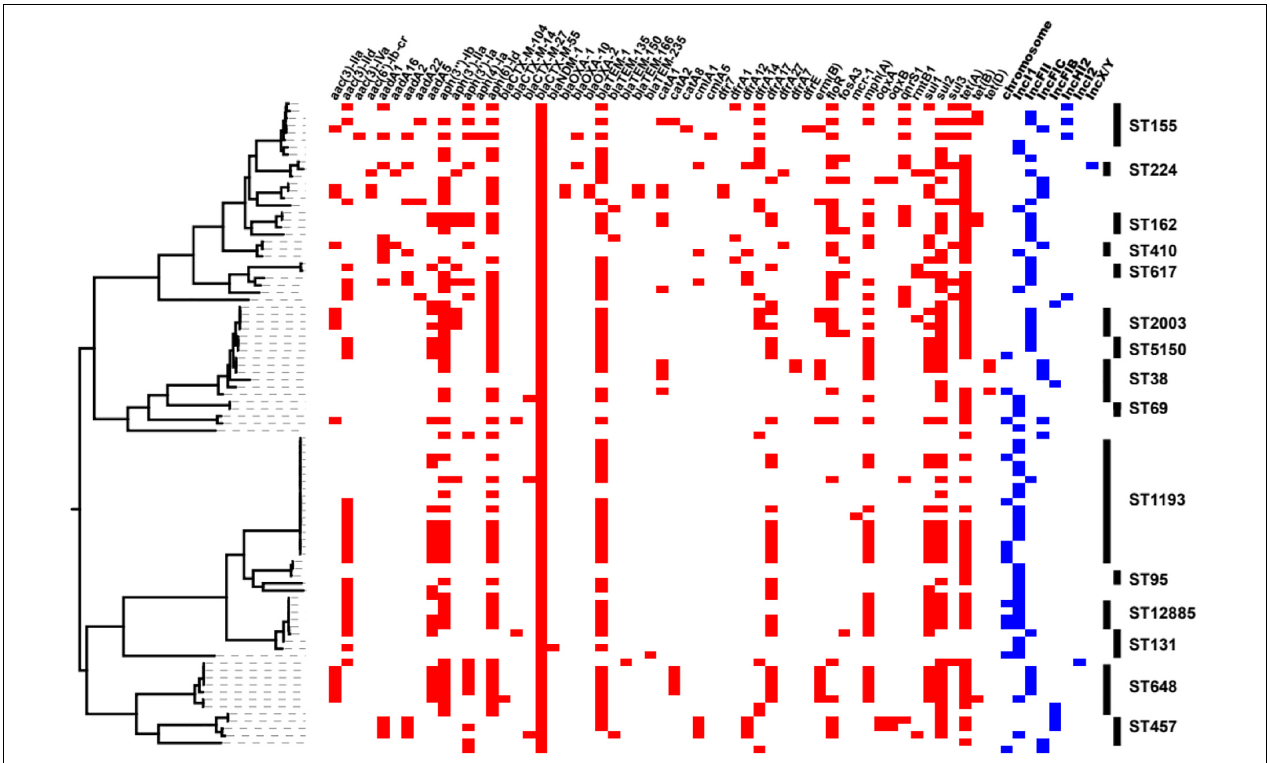
FIGURE 3 | Heatmaps of partial resistance genes, ST types and bla CTX − M − 55 gene locations combined with the phylogenetic tree of the bla CTX − M − 55 isolates. The phylogenetic tree was drawn using PARSNP software. The red box indicates that the isolate contains relevant resistance gene, and the blue box indicates the location of the bla CTX − M − 55 gene in the isolate. The rightmost end of the figure shows the ST type ( n ≥ 2) of the isolates.